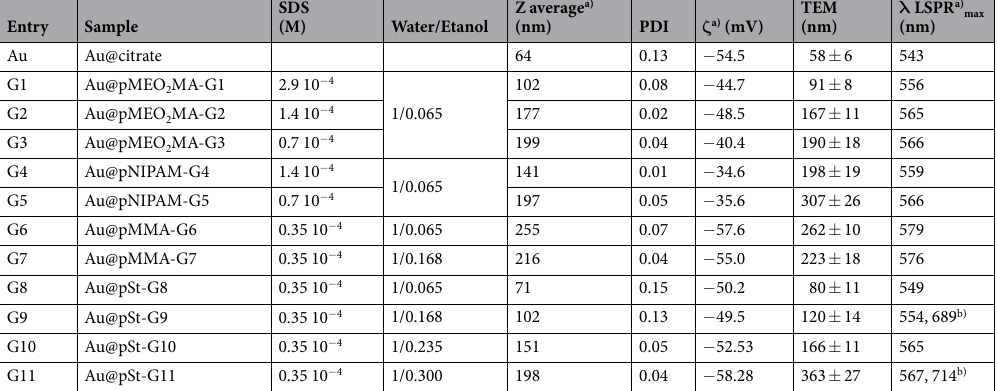
Table 1. Summary of Surfactant Concentration (SDS), Z Average Diameter and Polydispersity (PDI) and Zeta Potential ( ζ ) by DLS, Size Diameter by TEM ( ± Standard Deviation) and Surface Plasmon Band Wavelength ( λ LSPR max ) of Hybrid Nanoparticles with Different Polymer Shells. a) Z-average, ζ and λ LSPR max for Au@ pMEO 2 MA and Au@pNIPAM systems were determined at T 10 °C above the VPTT. b) λ LSPR max for Au@pSt